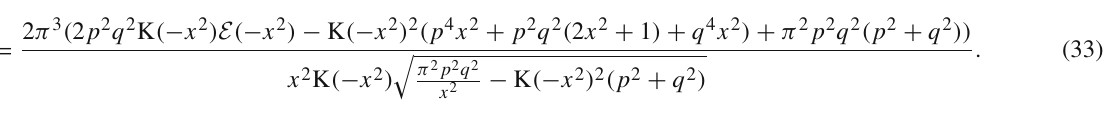
is the scaling of the figures since l 2 and l 3 and ∂ E ∂ as p and q